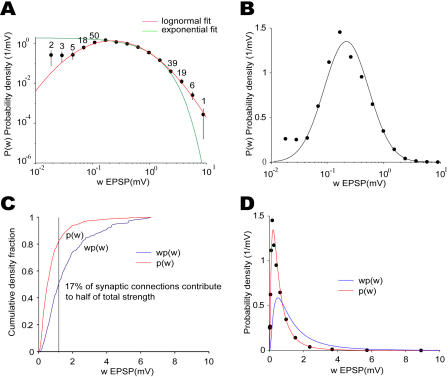
Distribution of Synaptic Connection Strength Has a Heavy Tail(A) Estimated probability density function in log–log space, with both lognormal fit (p[w] = 0.426exp[−(ln[w] + 0.702)2/(2 × 0.9355)2]/w) and exponential fit (p[w] = 1.82exp[−1.683w]). Notice that the lognormal fit has a heavier tail than the exponential distribution. Error bars are standard deviations estimated by bootstrap method (not shown when narrower than the dot). The numbers on top on the dots are the actual counts (not shown when more than 50).(B) Estimated probability density distribution in semilog space, with the lognormal fit. The lognormal function shows up as a normal function in the semilog space.(C) Empirical cumulative density function for both the probability distribution of synaptic strengths and the synaptic contribution (normalized product of probability and connection strength). They are generated directly from the data rather than the fits. The vertical line illustrates the fact that 17% of the synaptic connections contribute to half of the total synaptic strengths.(D) Probability density function of synaptic connection strengths p(w) fitted by a lognormal function and the synaptic contribution defined as the product of the strength, w, and p(w). The total areas under both curves are normalized to 1.